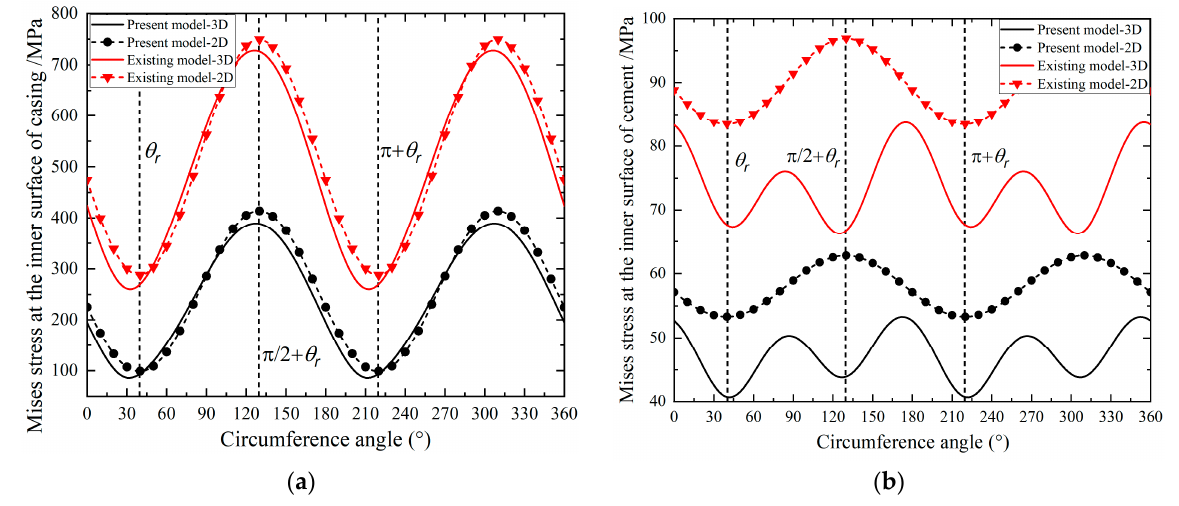
Figure 10. The Mises stress distribution in 2D and 3D solution at the inner surfaces of ( a ) casing and ( b ) cement using the present and existing model. Two-dimensional von Mises stress distribution with a changing circumference angle shows symmetry θ r , while anti-plane shear stress in the 3D model breaks it. In this case, an inclined wellbore with a deviation azimuth of 30° and a deviation angle of 60° is considered.